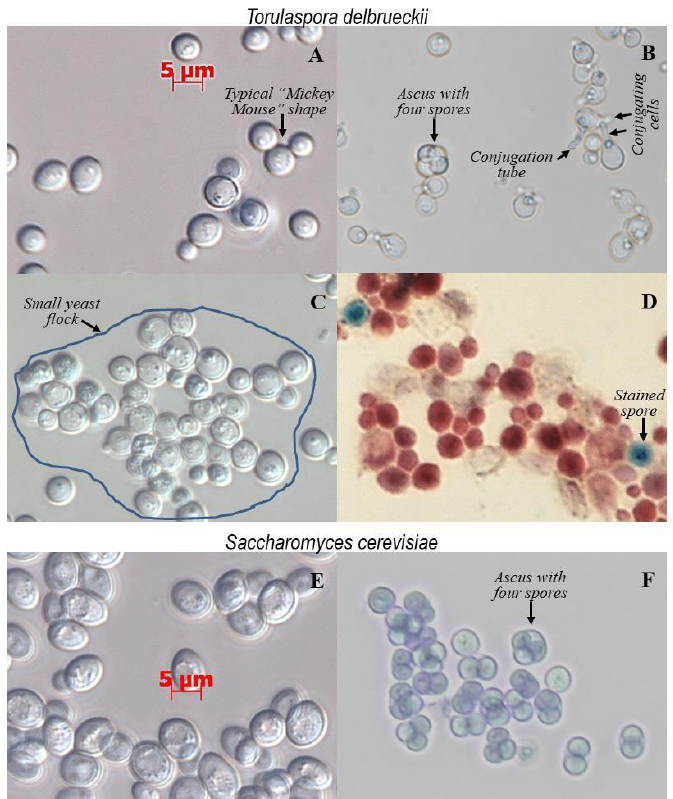
Figure 1. Vegetative cells ( A , C , E ) and spores ( B , D , F ) of T. delbrueckii and S. cerevisiae for comparison. Photomicrographs were taken using Nomarski (vegetative cells) or bright-field illumination (spores) with a Nikon Eclipse 600 microscope equipped with a 60× objective. ( B , F ) Spores from Minimal Sporulation Medium. ( D ) Spores from YEPD agar stained with malachite green.